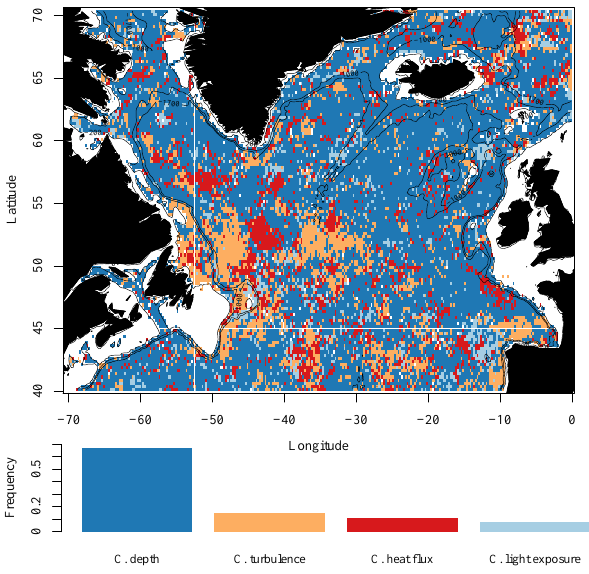
Figure 3. Selected model for each 0 . 25 ◦ pixel (top) and relative fre- quency of each model (bottom). C. depth: critical depth; C. turbu- lence: critical turbulence; C. light exposure: critical light exposure; C. heat flux: critical heat flux. Only pixels where the weight of the winning model is higher than 30% and the bottom depth exceeds 200m are used in this